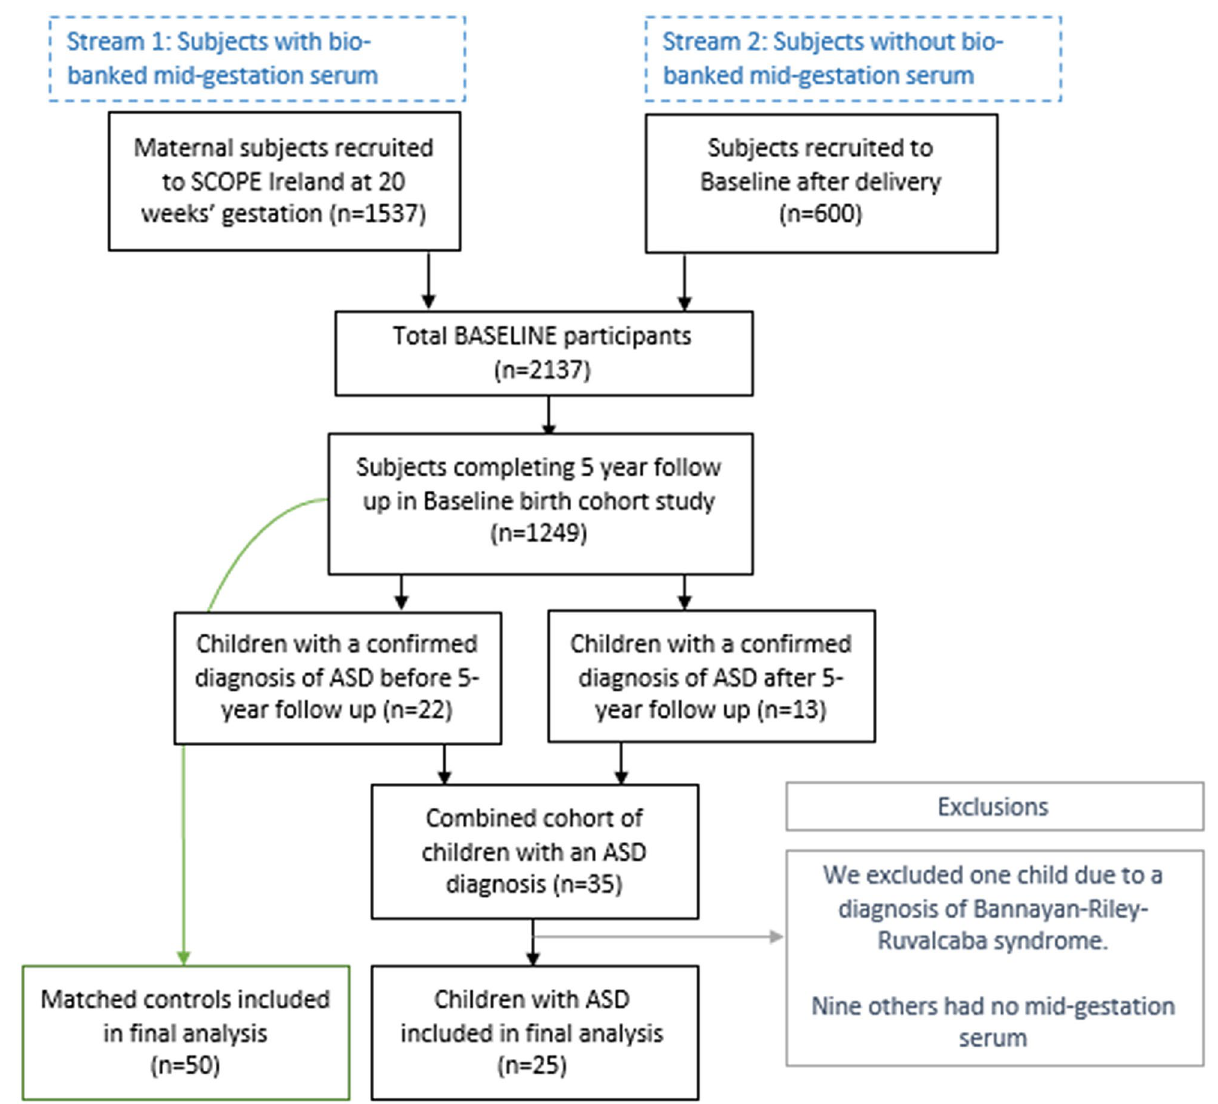
Figure 1. Recruitment numbers flow chart: Participants in Baseline were drawn from two streams, those recruited at 15-week booking appointment (n = 1537) and those recruited in the immediate post-natal period (600), totalling 2137 participants. 1249 participants completed follow up at 5 years. Of those, Twenty-two participants had a known ASD diagnosis at 5-year follow up; a further 13 were diagnosed with ASD between 5 and 10 years of age. Of the 35 participants with a diagnosis of ASD, 10 were excluded from this analysis. One child had a significant genetic diagnosis (Bannayan-Riley-Ruvalcaba syndrome); none of the other nine children had stored midgestational serum. This left 25 participants with ASD who were then matched 2:1 with healthy Cytokine analysis. To determine whether a significant difference existed between the mid-gestation (20- week) inflammatory profiles of mothers of ASD and neurotypical children Meso Scale Discovery ECL assays were performed. Of the original eight cytokines examined, IL-4 was significantly altered ( p -value 0.04). Cytokine concentrations were compared using Mann–Whitney U test. Expression of the seven other cytokines did not dif- fer significantly. In Table 3 we present the number of samples analysed and the sample attrition rates. IL-17A was examined using a multiplex system and an ultrasensitive single analyte assay, and neither indicated a significant difference between groups. A summary of the cytokine analysis results is presented in Table 4, and the individual analyte results are presented in Fig. 2 through Fig. 10.